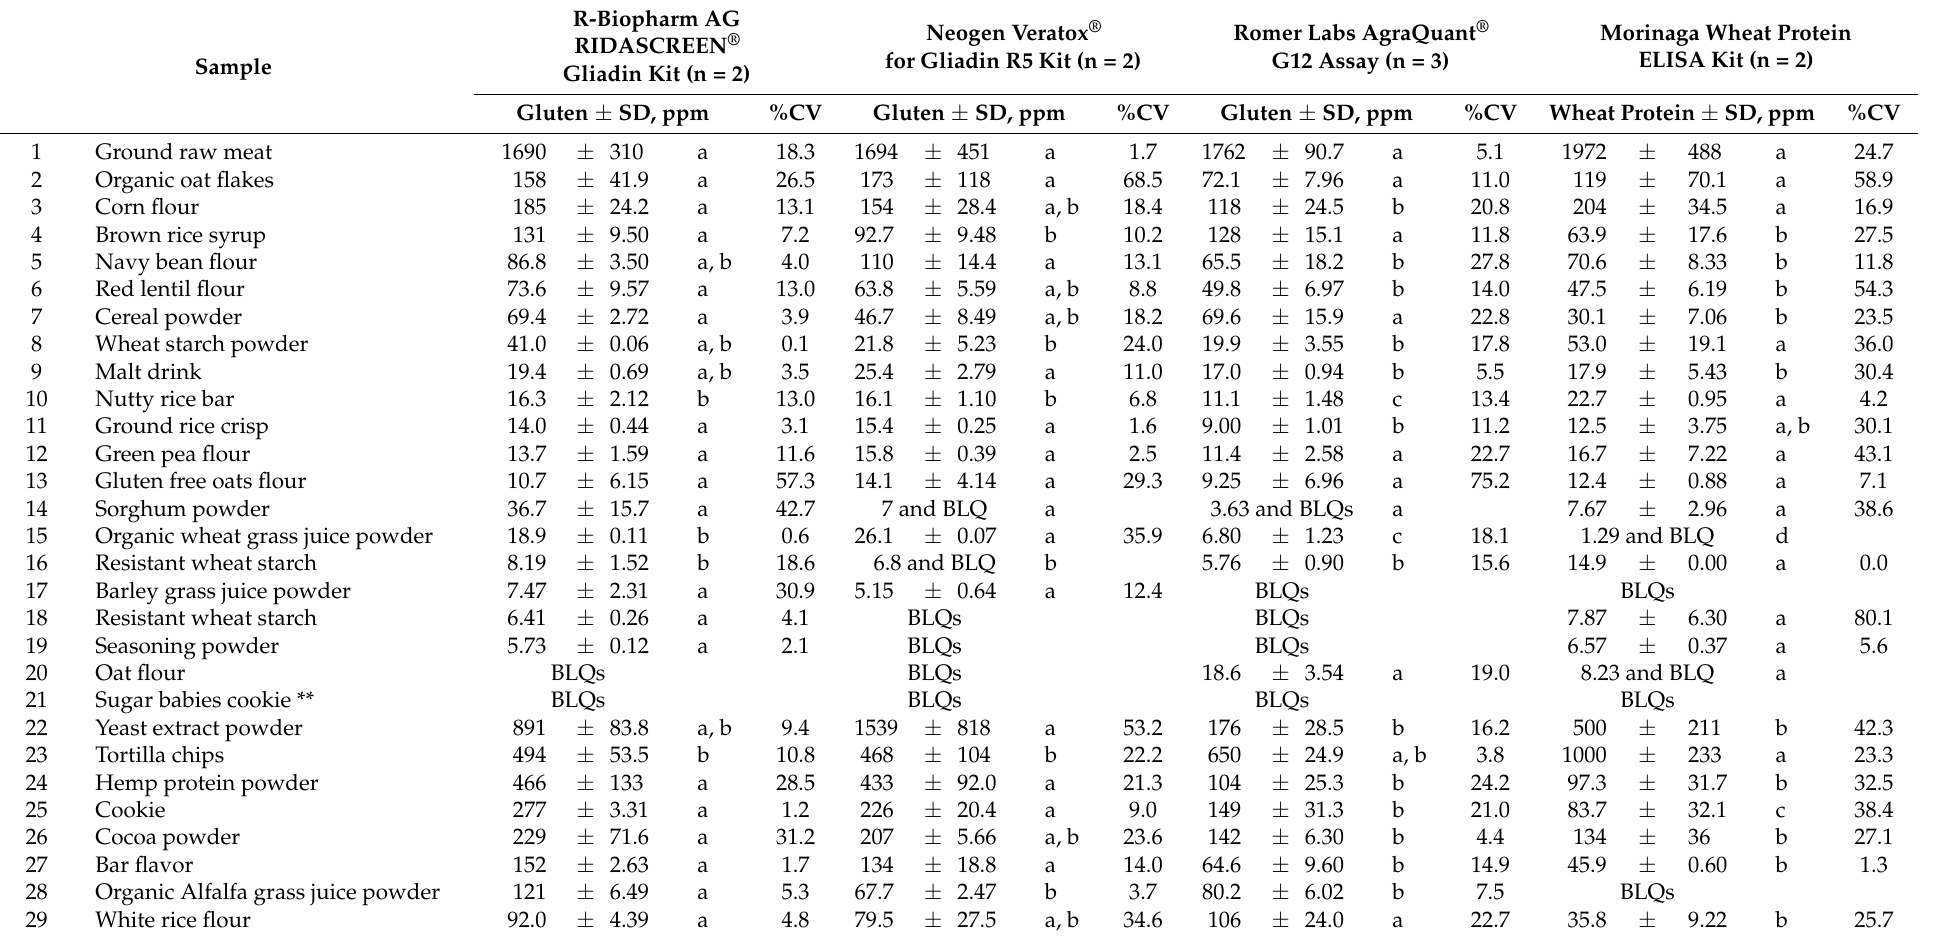
Table 2. Analysis of gluten/wheat protein in foods and ingredients by the four commercial sandwich ELISA